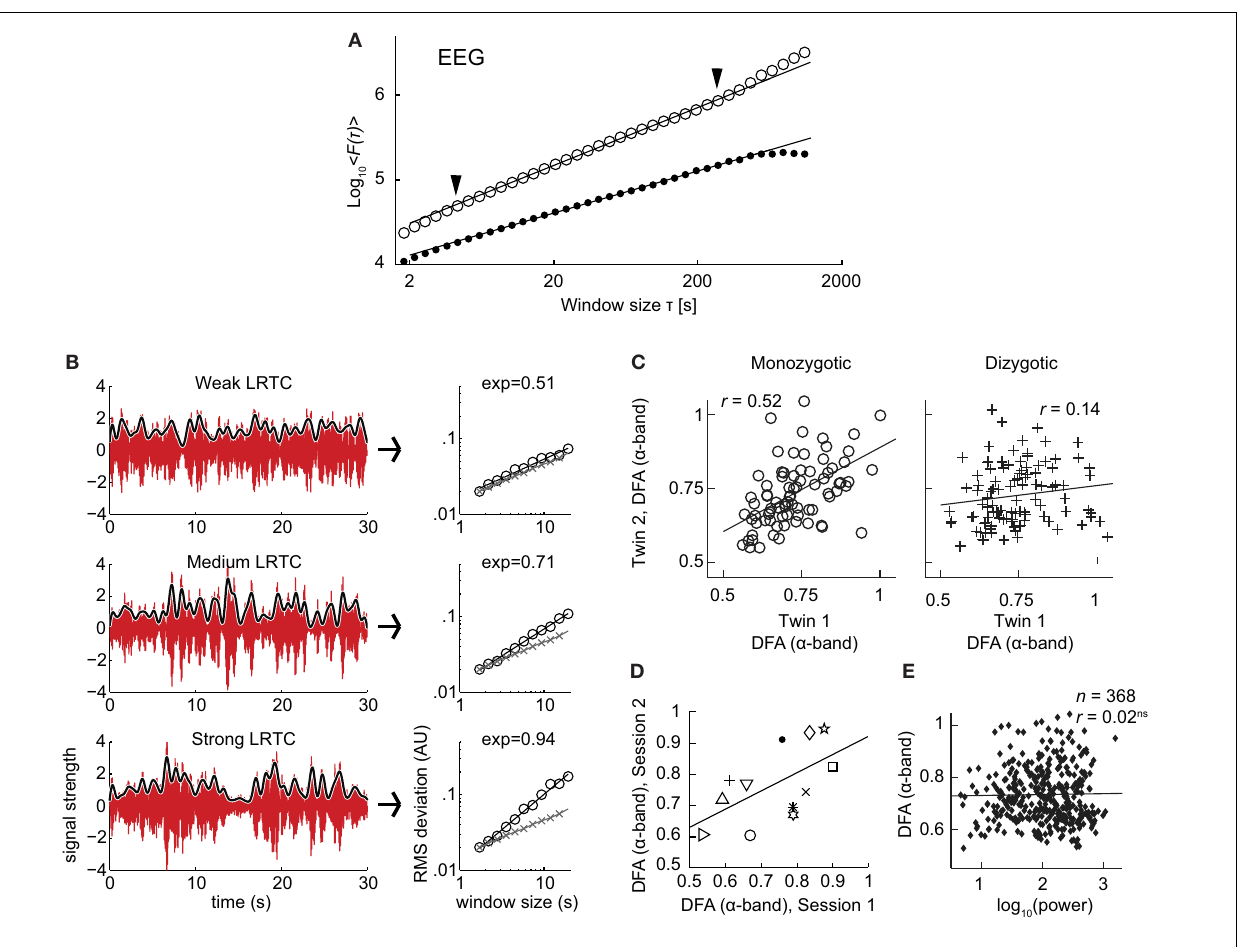
function. (Figure modified from Smit et al., 2011). (C) Individual differences in long-range temporal correlations in alpha oscillations are to a large extent accounted for by genetic variation, as seen by the difference in correlations of DFA exponents between monozygotic and dizygotic twins (Figure modified from Linkenkaer-Hansen et al., 2007). (D) DFA has high test-retest reliability. DFA exponents from the amplitude modulation of alpha oscillations, two sessions with an interval of 6–28days, symbols indicates different subjects (Figure modified from Nikulin and Brismar, 2004). (E) The DFA exponent is independent of oscillation power. Data were recorded using EEG on 368 subjects during a 3min eyes-closed rest session (Figure modified from Linkenkaer-Hansen et al.,